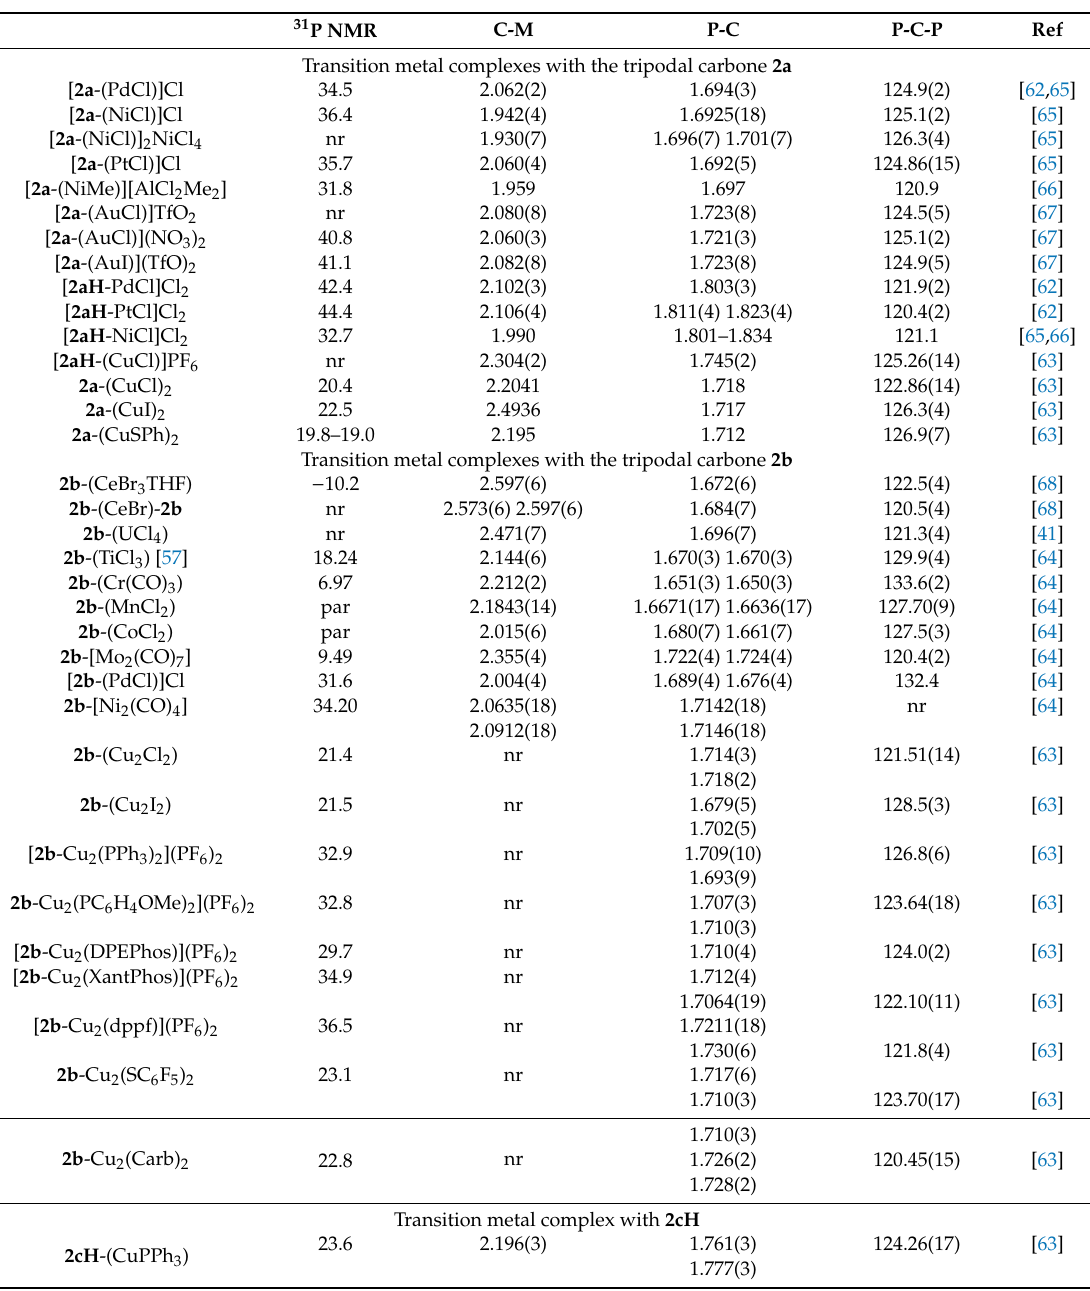
Table 2. Transition metal complexes with the phosphine based pincer ligands 2a and the pyridyl based pincer ligand 2b ; C-M and P-C distances are included and 31 P NMR shifts in